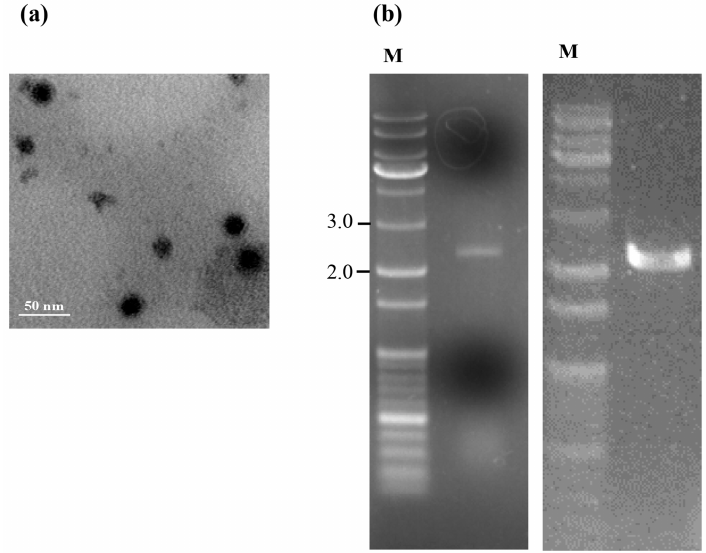
Figure 1. Profiles of isometric viral particles isolated from T. atroviride NFCF394. ( a ) Purified virus particles were negative-stained with 2% uranyl acetate and examined using transmission electron microscopy. Scale bar, 50 nm. ( b ) Agarose gel electrophoresis of the dsRNAs extracted from viral particles (left) and mycelia (right) of virus-infected T. atroviride NFCF394. Lane M contains the DNA size standard and the numbers indicate the size in kbp.